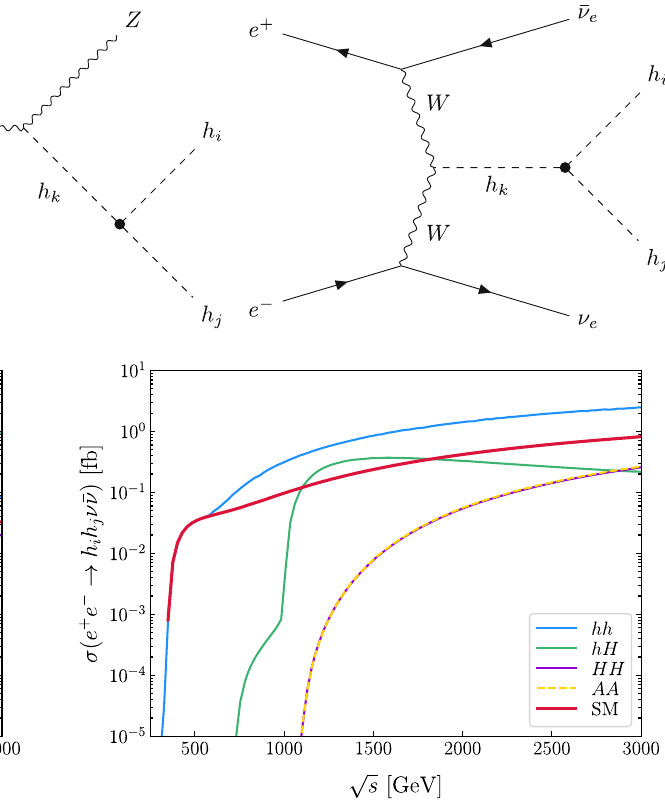
√ = 24000 GeV 2 .ThenumericalvaluesofthetripleHiggscouplings s for m 2 12 corresponding to these input parameters are κ λ = 0 . 99, λ hhH = − 0 . 3, λ = 4 . 0 and λ = 1 . hHH HHH